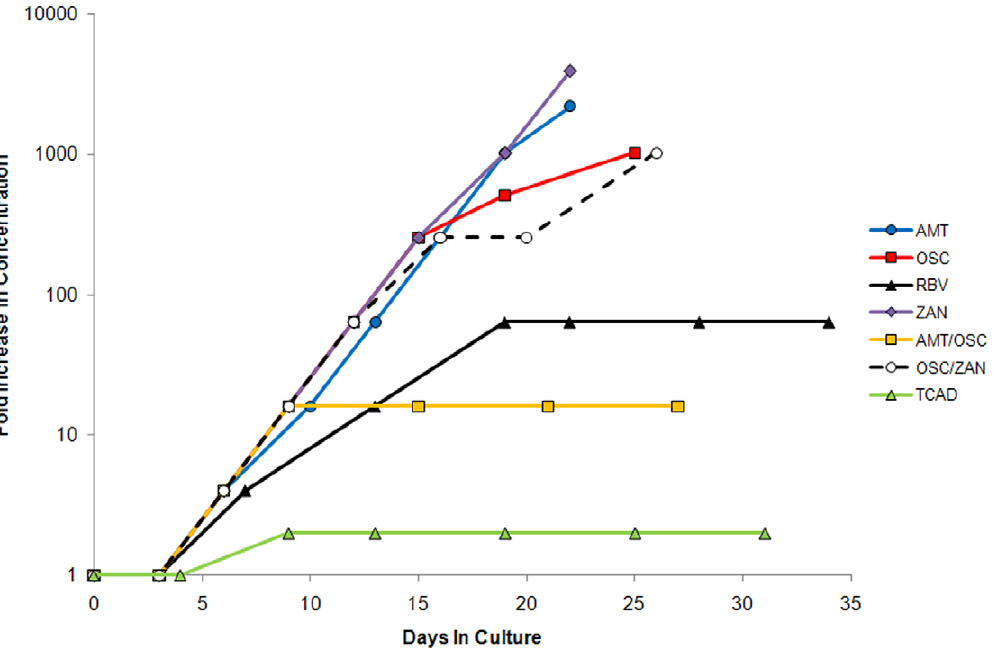
Figure 3. Passage History of Wild Type Influenza A/Hawaii/31/07 under Escalating Drug Concentrations. Wild type influenza A/Hawaii/ 31/2007 (H1N1) virus was passaged in the presence of escalating concentrations of each drug regimen for a total of $ 25 cumulative days in culture, or until the drug concentration reached the 50% of the cytotoxic concentration (TC 50 ) of the drug as a single agent.